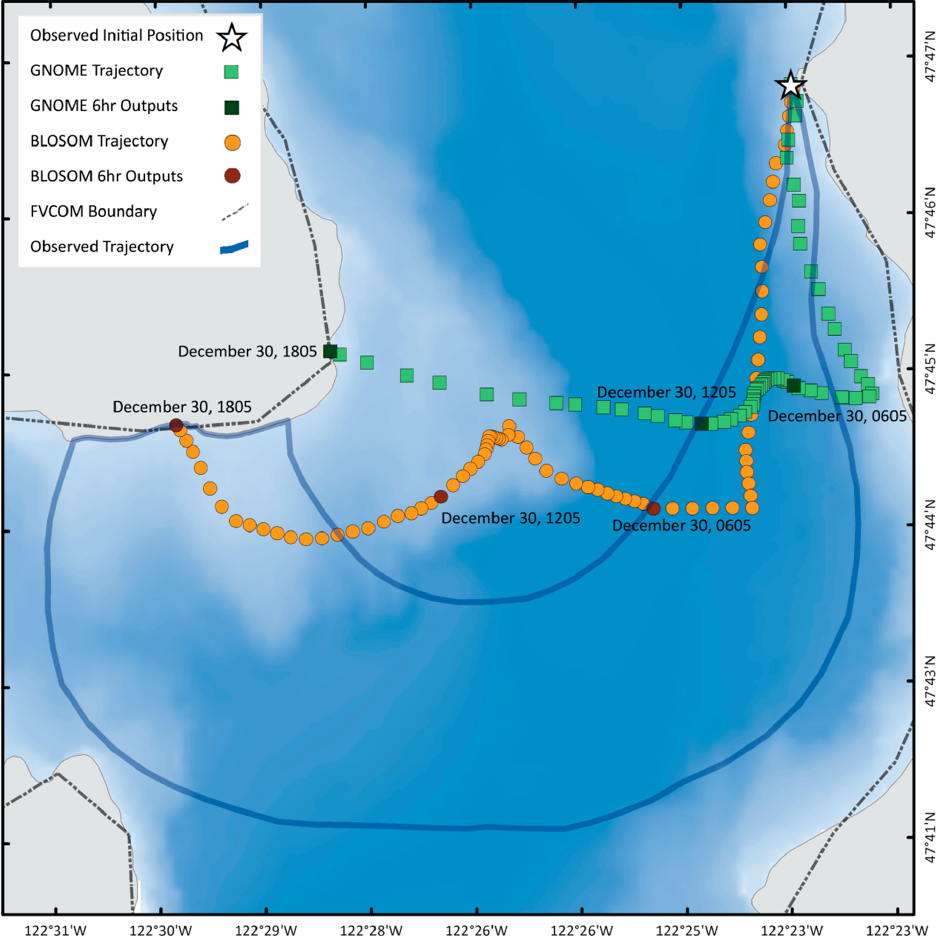
Figure 12. GNOME and BLOSOM trajectories diverge due to including, or not, the effect of earth’s rotation on wind forcing; test 3, part 1.